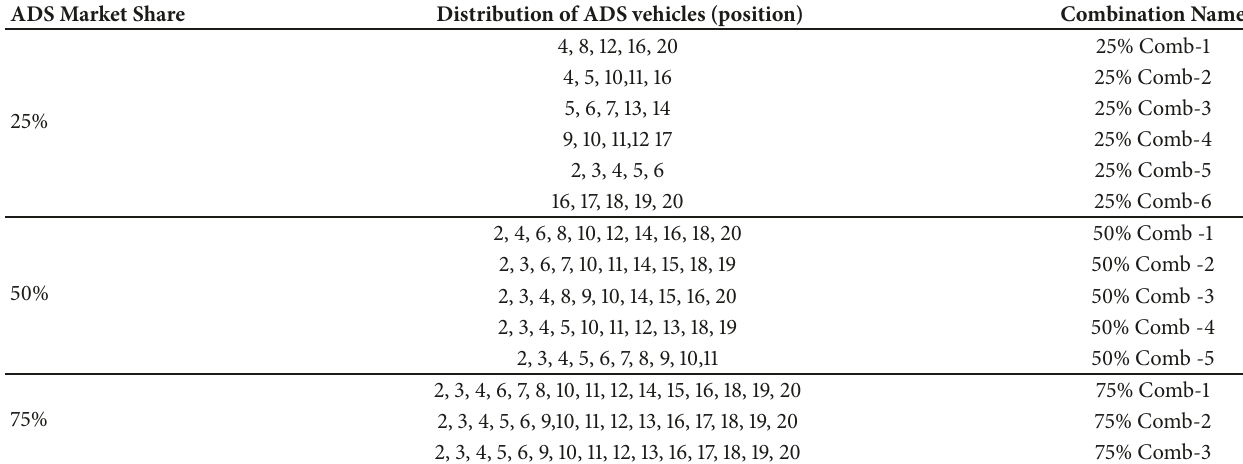
Table 1: List of ADS vehicle combinations simulated for different market